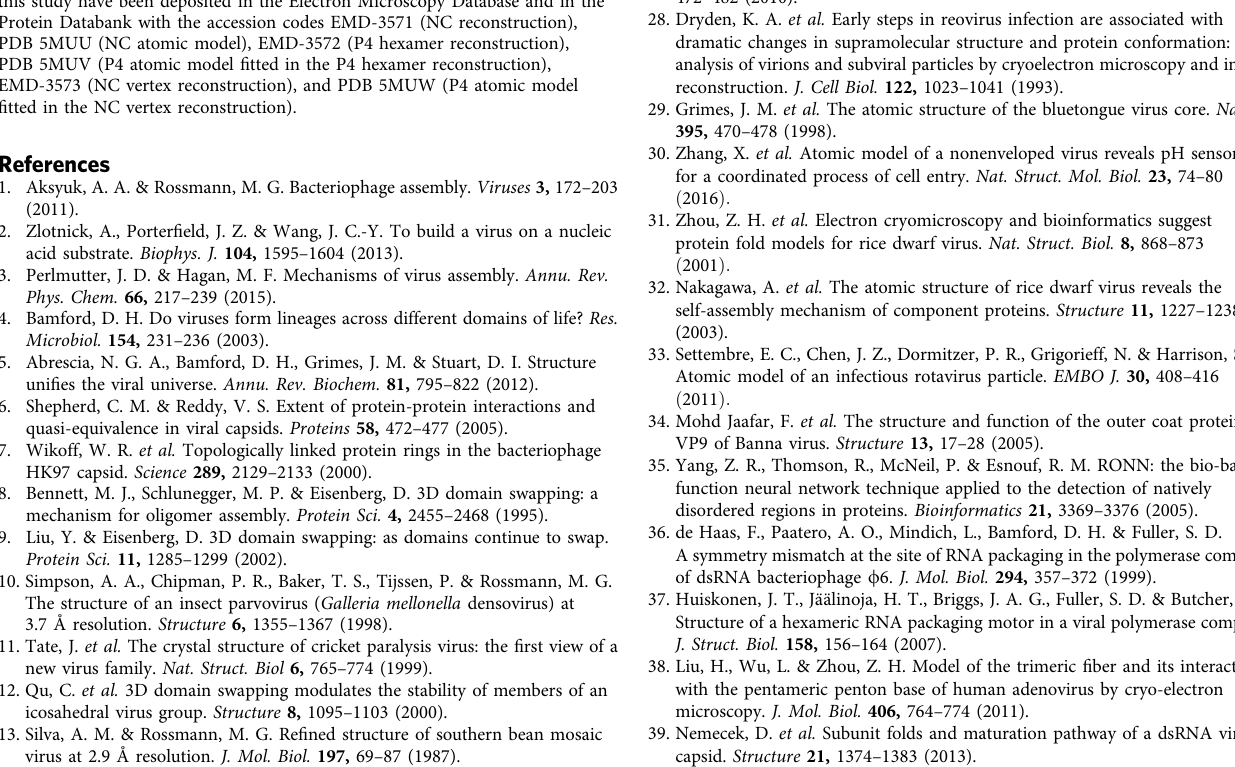
for bulky residues facilitated building the full atomic model of P8 (L3-Y147) and the C terminus of P4 (R292-L332) with side-chains. The crystal structure of f 6 P1 (PDB:4K7H) was fitted in the NC map using COOT 55 as a rigid body in two different positions corresponding to subunits P1 A and P1 B . P1 A and P1 B main-chains and side-chains were adjusted using manual and real space fitting in COOT. The crystal structure of f 6 P4 (PDB:4BLO) 19 was fitted in the P4 hexamer and NC vertex localized reconstructions as a rigid body in UCSF Chimera 56 . Atomic models for all of the chains in the asymmetric unit (P1 A , P1 B , P4 C terminus and ten copies of P8) were refined in Phenix.real_space_refine applying secondary structure, rotamer, and Ramachandran plot restraints. In addition, non-crystallographic symmetry restraints were applied on P8 chains 57 . The models were validated with MOLPROBITY 58 . Atomic model refinement statistics are summarized in Table 3. Disordered regions in P4 sequence (UniProt:P11125) were predicted with RONN 35 and changes in subunit-subunit angles calculated in UCSF Chimera 59 . Data availability . Density maps and atomic models that support the findings of this study have been deposited in the Electron Microscopy Database and in the